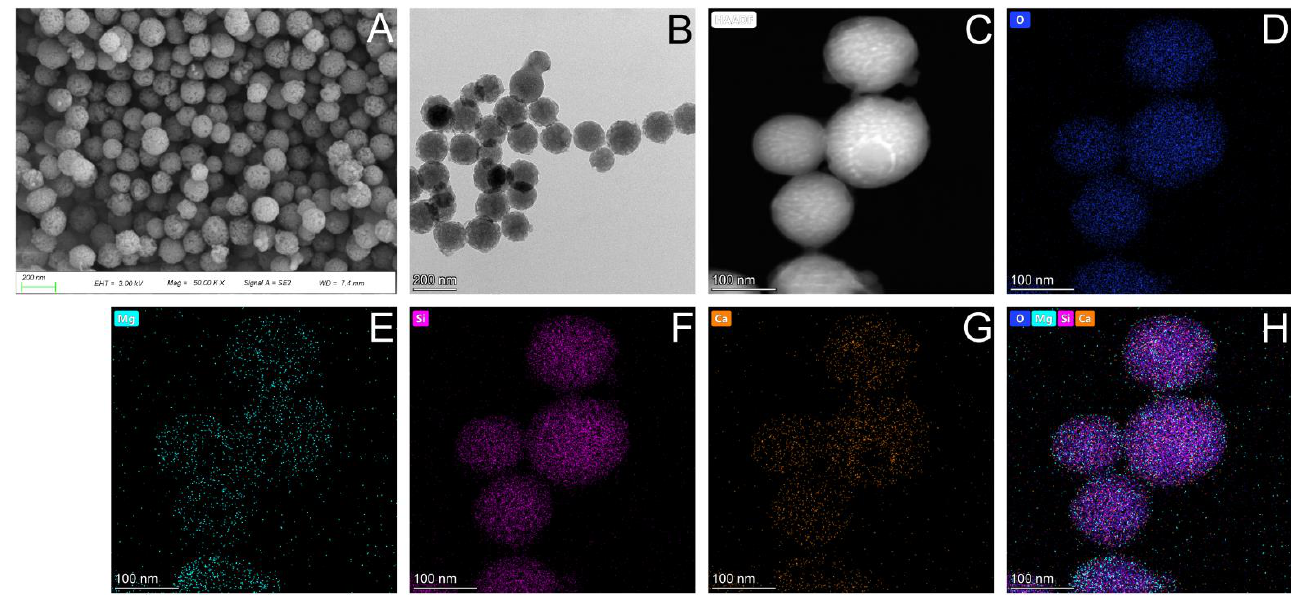
Figure 1. Characteristics of Mg-containing bioactive glass nanospheres (Mg-BGNs): ( A ) Scanning electron microscopy (SEM) image; ( B ) Transmission electron microscopy (TEM) image; ( C ) Scanning transmission electron microscopy (STEM) image; and ( D − H ) element maps (O, Mg, Si, Ca) of Mg-BGNs.